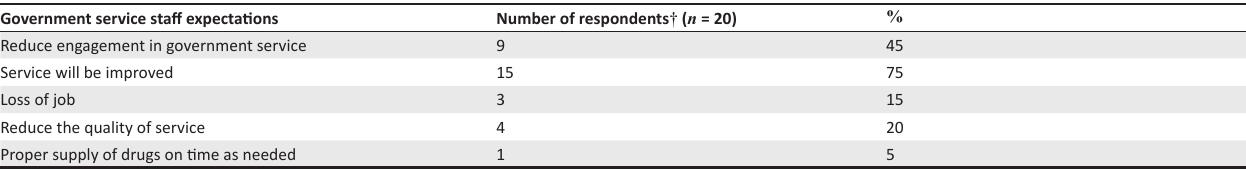
TABLE 5: Government service staff expectations of outcomes of privatisation schemes. Government service staff